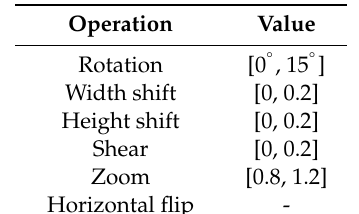
Table 2. Parameter set for data augmentation.